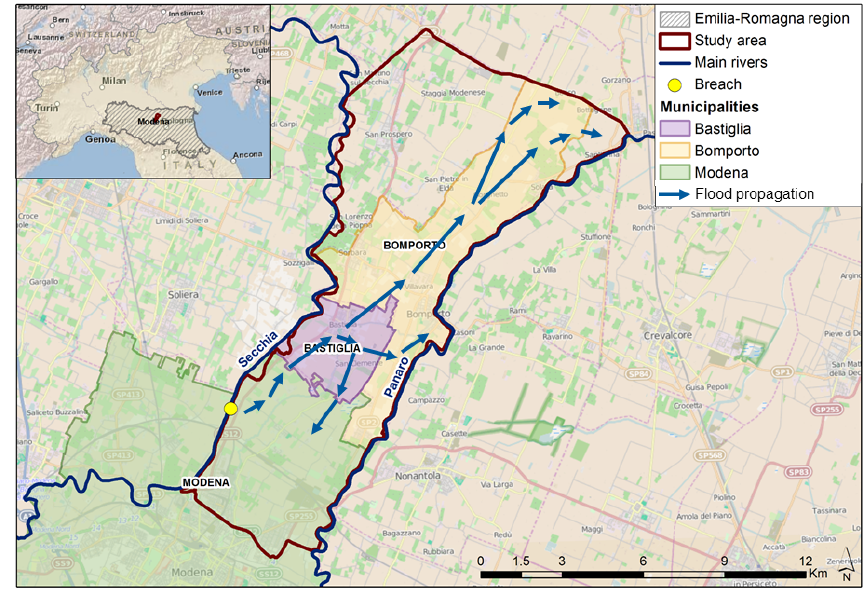
Figure 1. Study area, Secchia and Panaro rivers, location of the breach (yellow dot), municipalities of interest (i.e., Bastiglia, Bomporto and Modena) and a schematic of the inundation